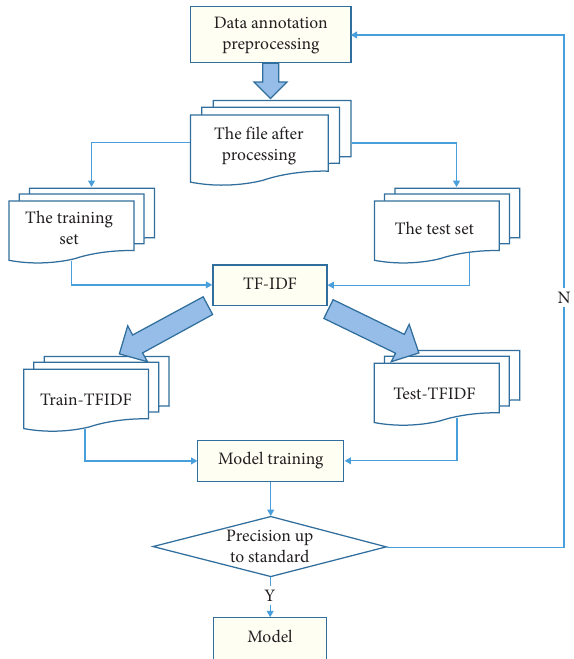
Figure 5: Model training flow